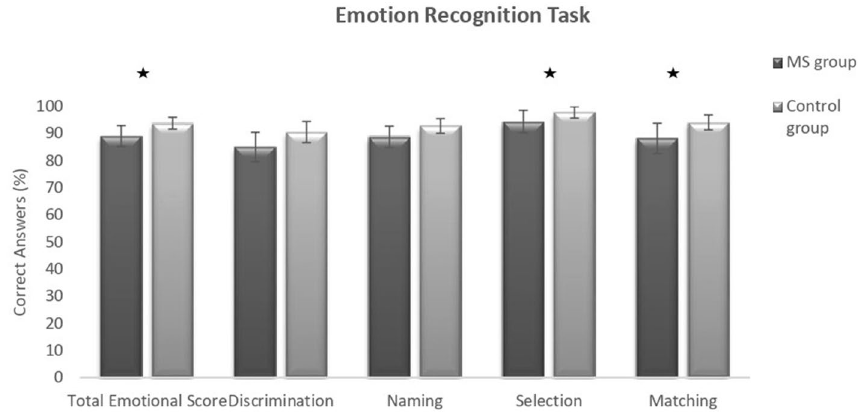
Figure 1. Emotion recognition task (FAB) results for the MS group and the control group. *Significant difference at p < 0.05.